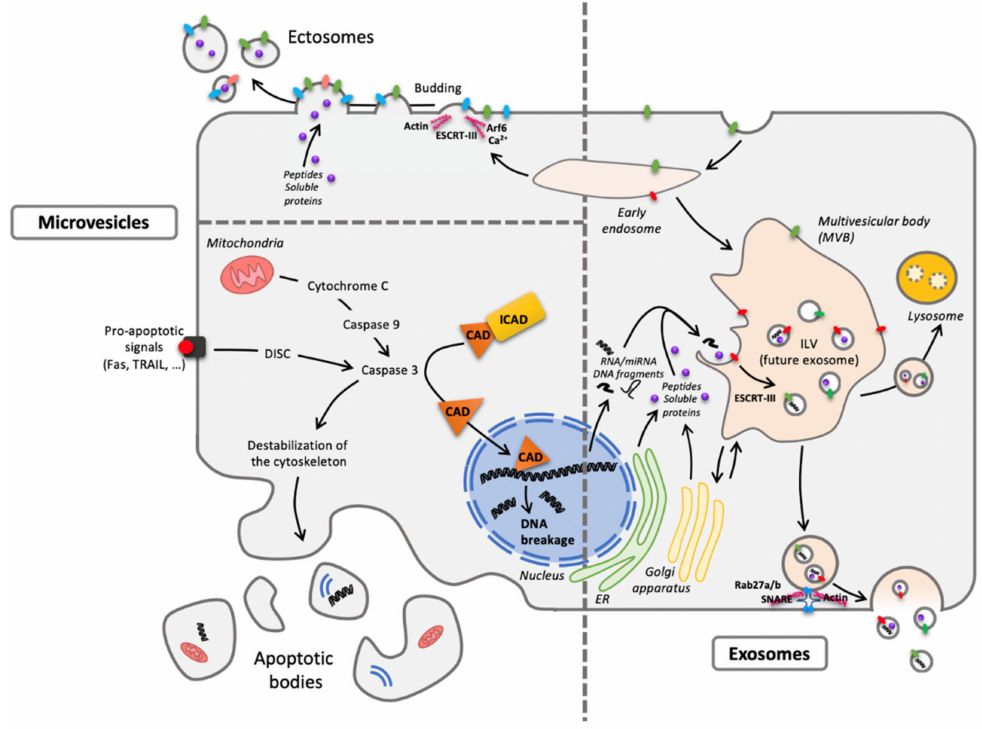
Figure 2. One cell, di ff erent extracellular vesicles (EVs). The two main forms are microvesicles (MVs) and EXOs di ff ering from their origin. Concerning MVs, ectosomes result from membrane budding (left pane, top) and apoptotic bodies from cellular vesiculation following apoptosis (left panel, bottom). As to exosomes (EXOs), they have an endosomal origin, generated by the formation of intraluminal vesicles (ILV) within the multivesicular body (MVB) (right panel) and released through exocytosis routes. Despite a quite homogenous diameter from 30 to 150 nm, EXOs are di ffi cult to distinguish (size exclusion chromatography or di ff erential ultracentrifugation) from the smallest MVs. Abbreviations: